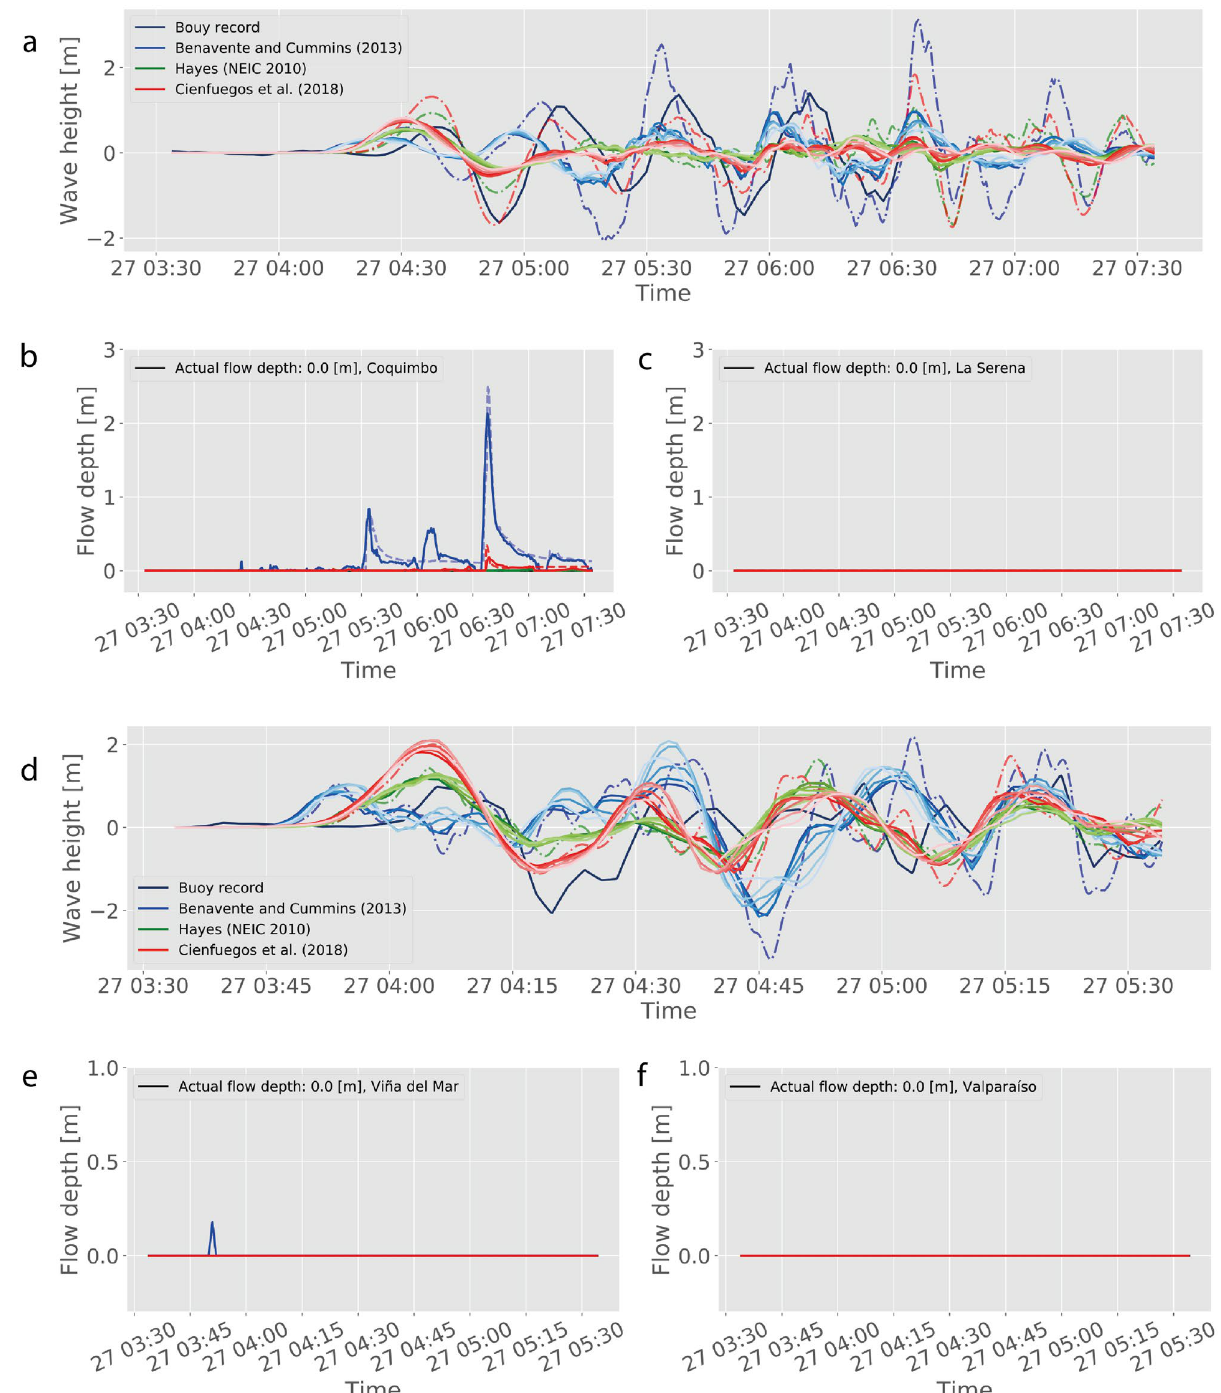
Figure 6. Hazard assessment for the Maule 2010 event. ( a, d ) The offshore tsunami time series at each of the six input buoys when modeled using as source condition that of Benavente and Cummins 72 (blue lines), Hayes (NEIC, 2010) taken from the SRCMOD database 71 (green lines) and the median model of Cienfuegos et al. 13 . The black line shows the nearest tide gauge record. Dashed lines correspond to the high-resolution tsunami HySEA model at the location of the tide gauge. ( b, c ) and ( e, f ) The time series of inundation as predicted by the corresponding network models and tsunami HySEA (dashed). Top panels are for Coquimbo-La Serena, and bottom panels correspond to Valparaíso-Viña del